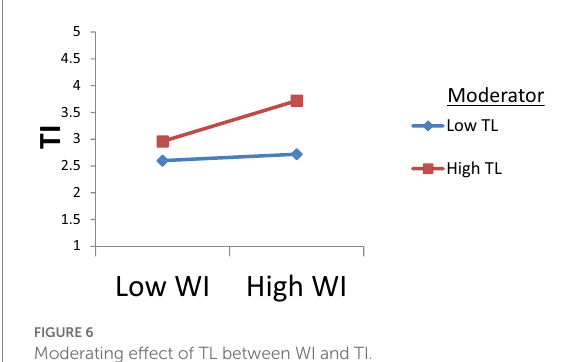
FIGURE 6 Moderating effect of TL between WI and